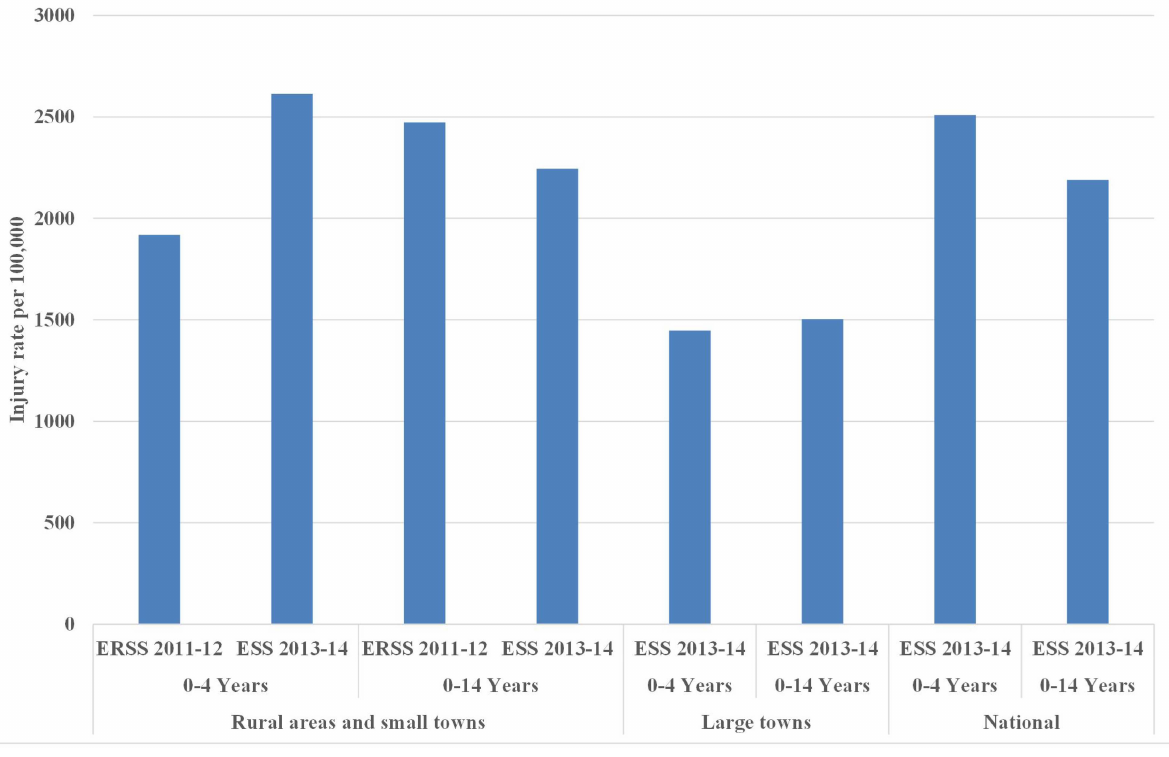
Fig 5. Injury rate per 100,000 children in rural areas, small towns, large towns, and the whole country: ERSS 2011–2012 and ESS 2013–2014. Source: Ethiopian Rural Socioeconomic Survey (ERSS) 2011–2012; Ethiopia Socioeconomic Survey (ESS) 2013–2014.